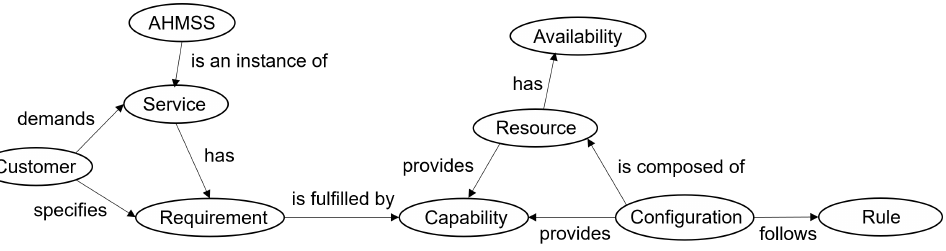
Figure 2. A domain model for an AHMSS, reproduced from